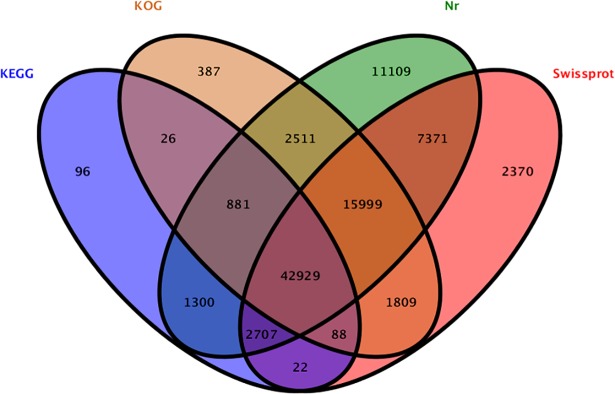
Venn diagram showing BLAST results of tea plants transcriptome against four databases.The assembled unigenes were used in BLAST searches against four pubic databases. The number of unigenes with significant hits against four database is shown at each intersection of Venn diagram.